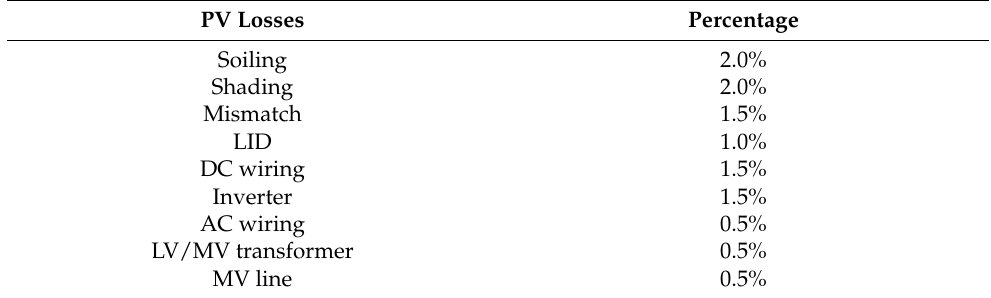
Table 1. Detailed solar PV system losses (not including PV module temperature and clipping losses). PV Losses Percentage Soiling 2.0% Shading 2.0% Mismatch 1.5% LID 1.0% DC wiring 1.5% Inverter 1.5% AC wiring 0.5% LV/MV transformer 0.5% MV line